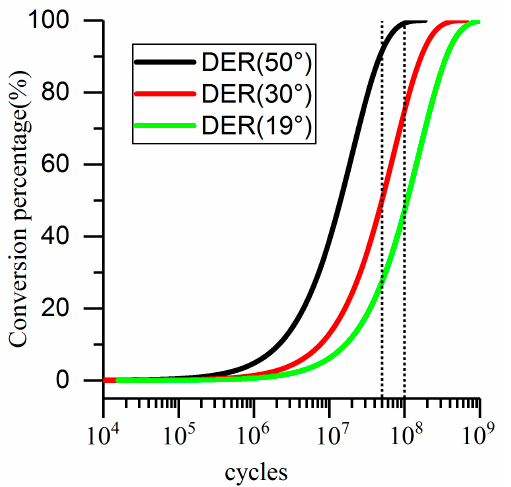
Figure 9. Effects of cyclic stress and temperature on the dark etching region (DER) formation under the experimental conditions (4.5 GPa).